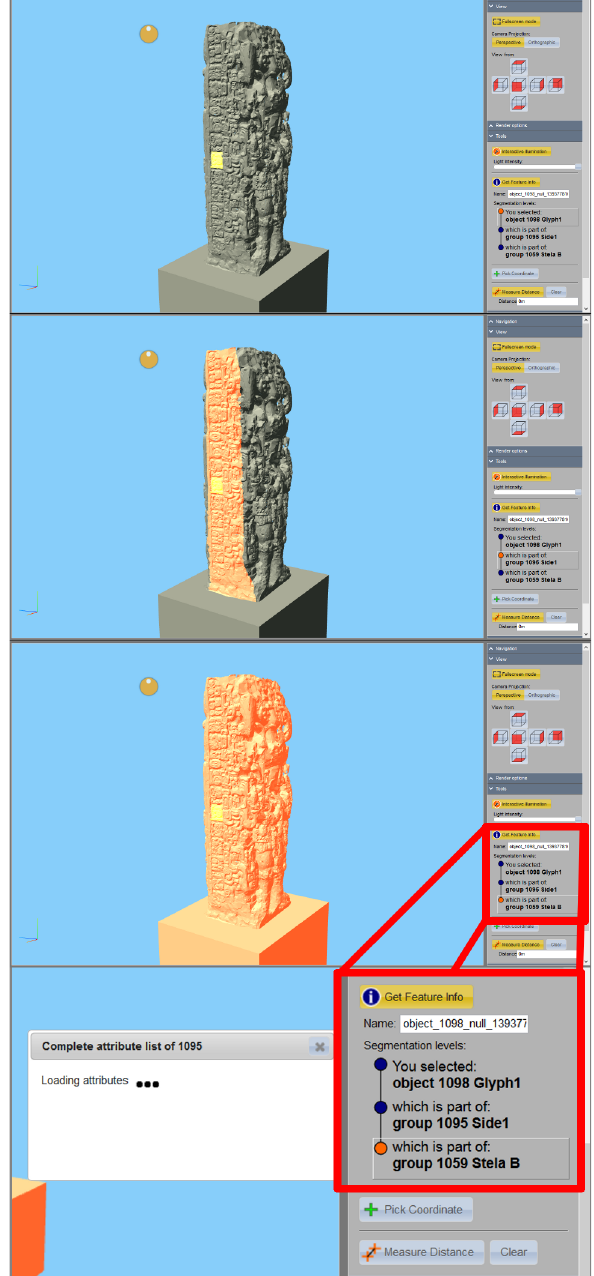
Figure 5. Interactive query of segmentation levels of a manually segmented